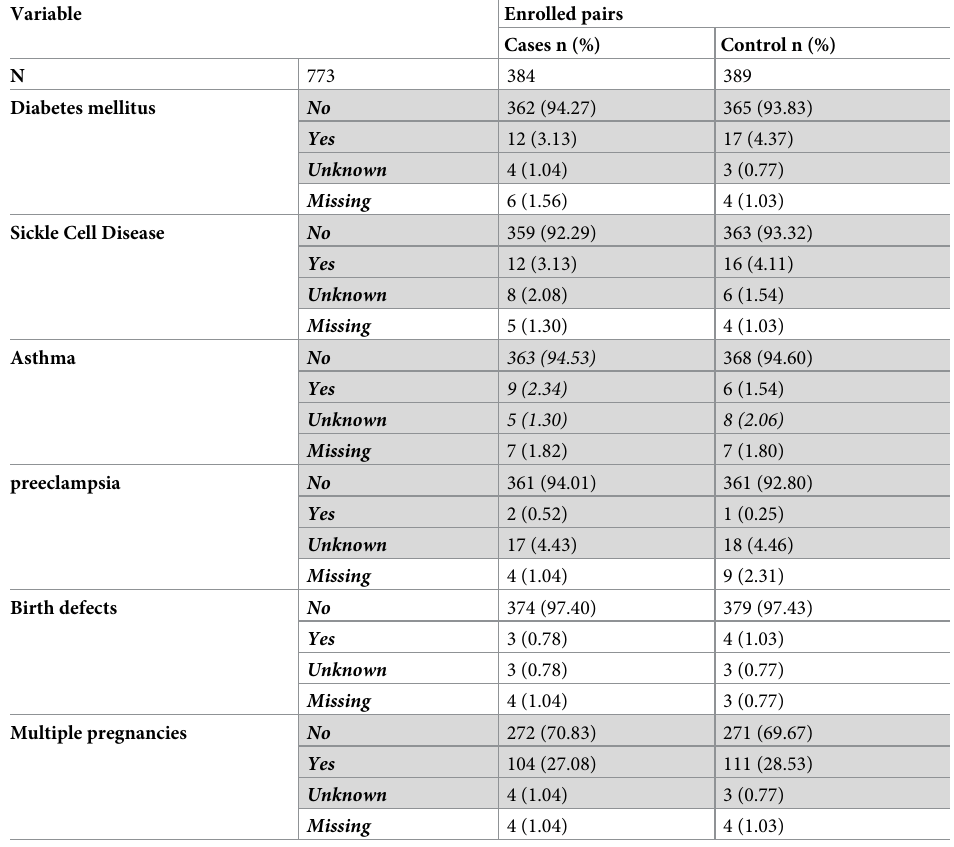
Table 5. Family History of risk factors for participants with and without